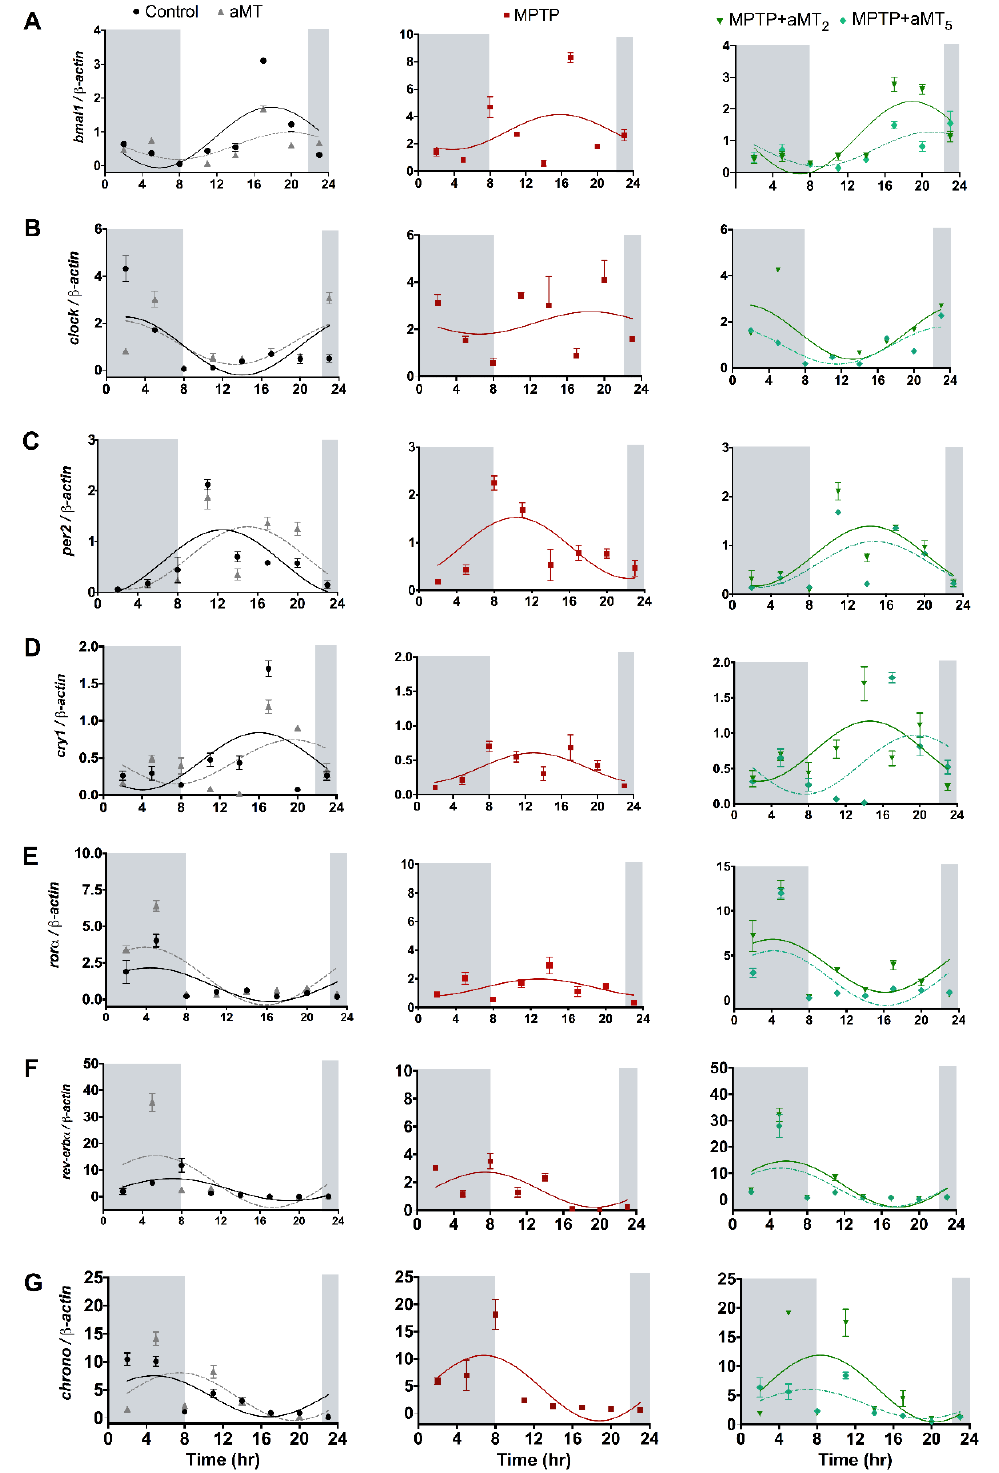
Figure 4. Relative expression of the clock genes: ( A ) bmal1 , ( B ) clock , ( C ) per2 , ( D ) cry1 , ( E ) ror α, ( F ) reverbα , and ( G ) chrono in control, aMT, MPTP, and MPTP+aMT treatments of zebrafish embryos. Data are expressed as means ± SEM. Measured in light and dark conditions (shaded part).